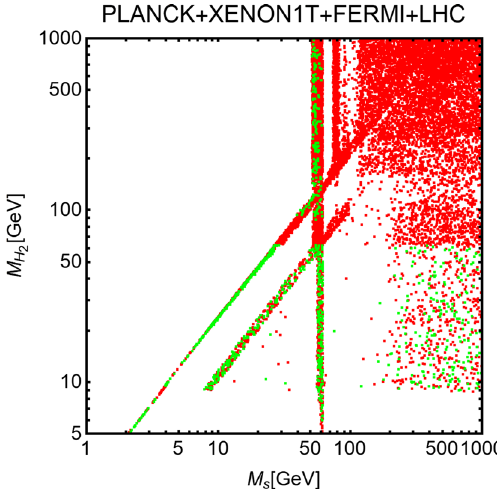
) plane, for the mixing model 2